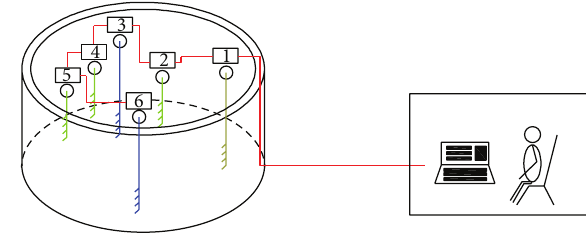
Figure 24: The temperature testing